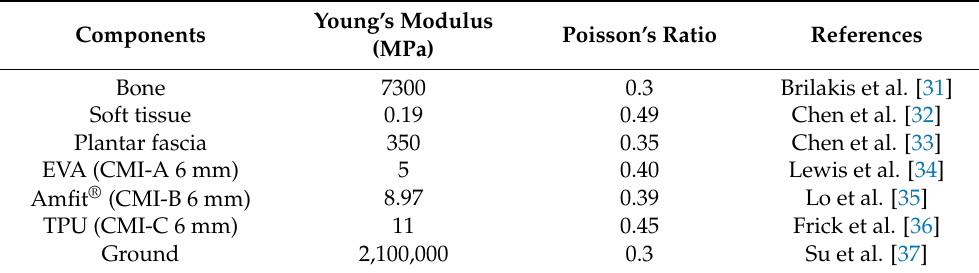
Table 2. The combination of materials for 2-layer custom-made insole.